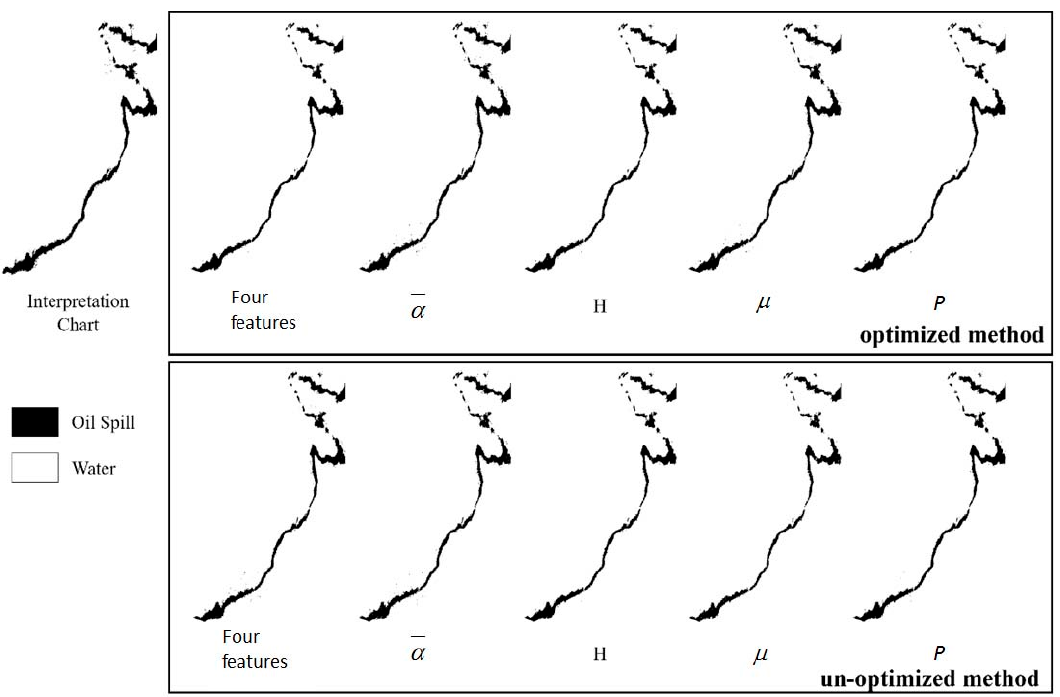
Figure 13. Classification results of Dataset 2.